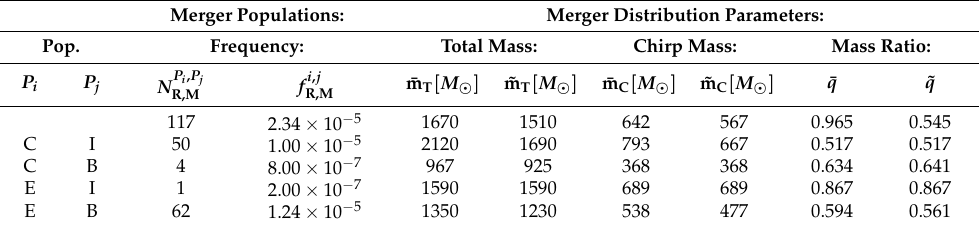
Table 11. Distribution mean and median values of the distributions in Figure 11, representing the merger profiles segregated by the population (cluster and ejecta) type integrated across all time-slices in the simulations starting at the time of first-merger (1M) t FM = 1.38 × 10 9 yr up to the present, for a ( N ) = 117 merger events throughout all realisations. Note that, as in the rest of the total of ∑ N R M R i = 1 paper, we use our convention that C, E, I, B, R and M stand for the cluster, ejecta, isolated, bounded, remaining and merged populations, respectively.